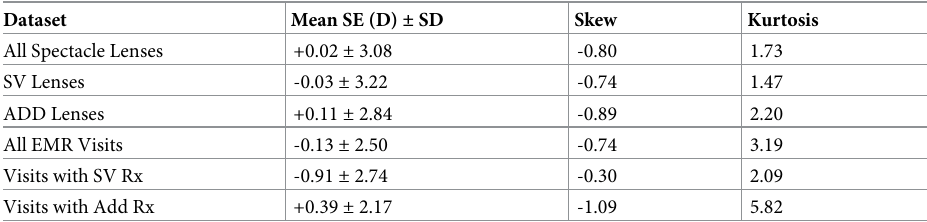
Table 1. Mean, range and distribution characteristics of spectacle lens and EMR